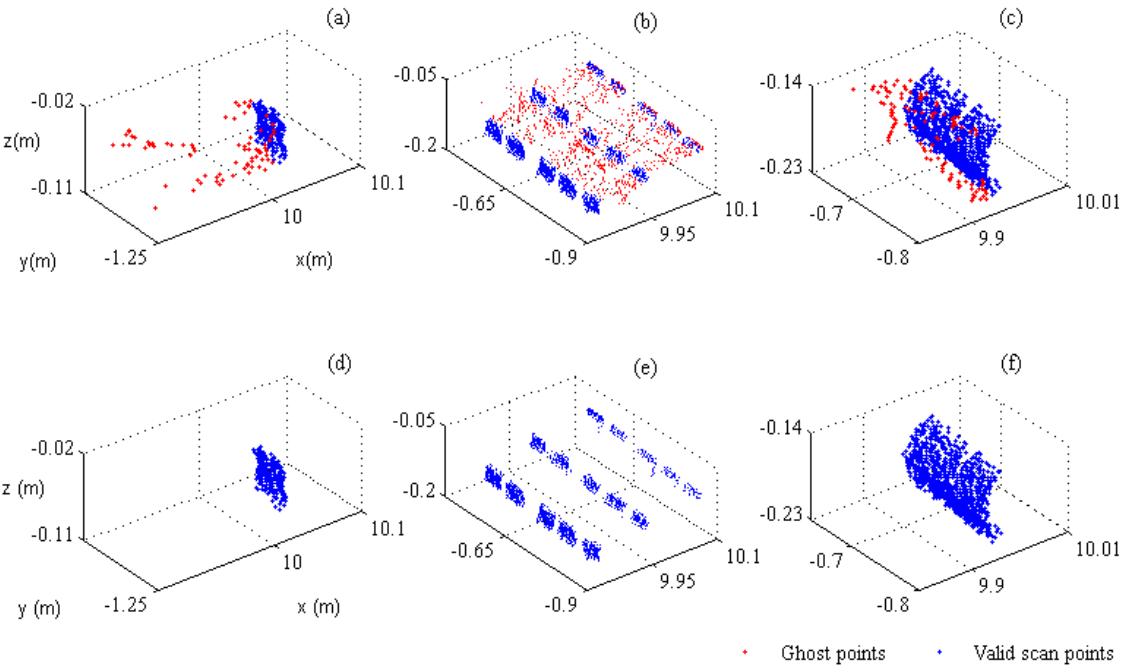
Figure 2. Visualization of the point clouds in the space under analysis for ( a ) the leaves setup; ( b ) the layers setup; and ( c ) the branches setup. Valid scan points are shown in blue, ghost points are shown in red; ( d – f ) show the valid scan points after manual extraction of ghost points, for the leaves setup, the layers setup, and the branches setup,